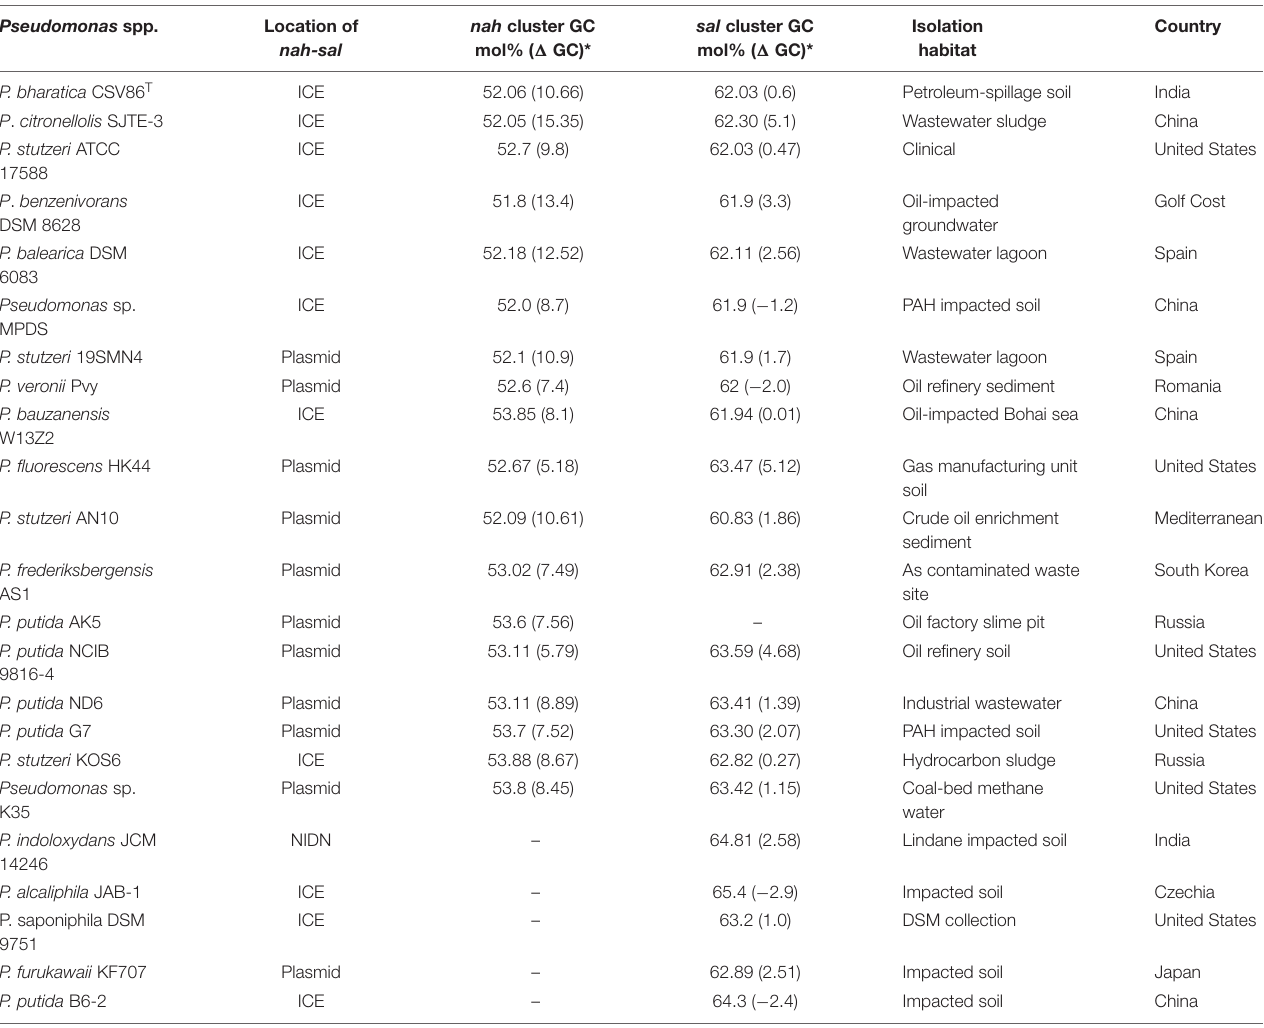
TABLE 2 | GC content and deviation (mol%, from genomic GC) of nah and sal cluster from different predicted ICEs and plasmids of various naphthalene degrading Pseudomonas spp. isolated from diverse biogeographic regions. Pseudomonas